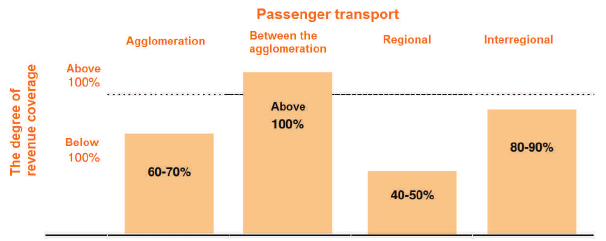
Fig. 1. Matrix of cost coverage with revenues in individual segments of the market of passenger